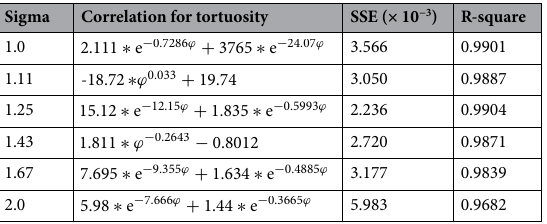
points of tortuosity do not completely follow this relationship, and this variation or error between the measured value and the adjusted value increases as the pore size increases. Starting with Fig. 12a, it can be seen that at porosities from 0.60 to 0.70 adjusted tortuosity values are obtained that slightly overestimate the real values. On the other hand, porosity values from 0.80 to 0.85 show tortuosity values below the real values. This relationship holds in Fig. 12b. Increasing the pore size, as shown in Fig. 12c, for the porosity of 0.55 the tortuosity begins to generate an error by underestimating the real value. Presenting this error with a slight increase in Fig. 12d as well as in the tortuosities of porosities from 0.60 to 0.65 and from 0.80 to 0.85 in the same figure. This error and especially the difference between the tortuosity values between 0.55 and 0.60 becomes quite noticeable in Fig. 12e,f. This means that the resistance between such porosities changes abruptly. On the other hand, the con- nectivity between them could have played an important role. An important factor to consider in this situation is the randomness of the media. This event can be a subject of study for future work.